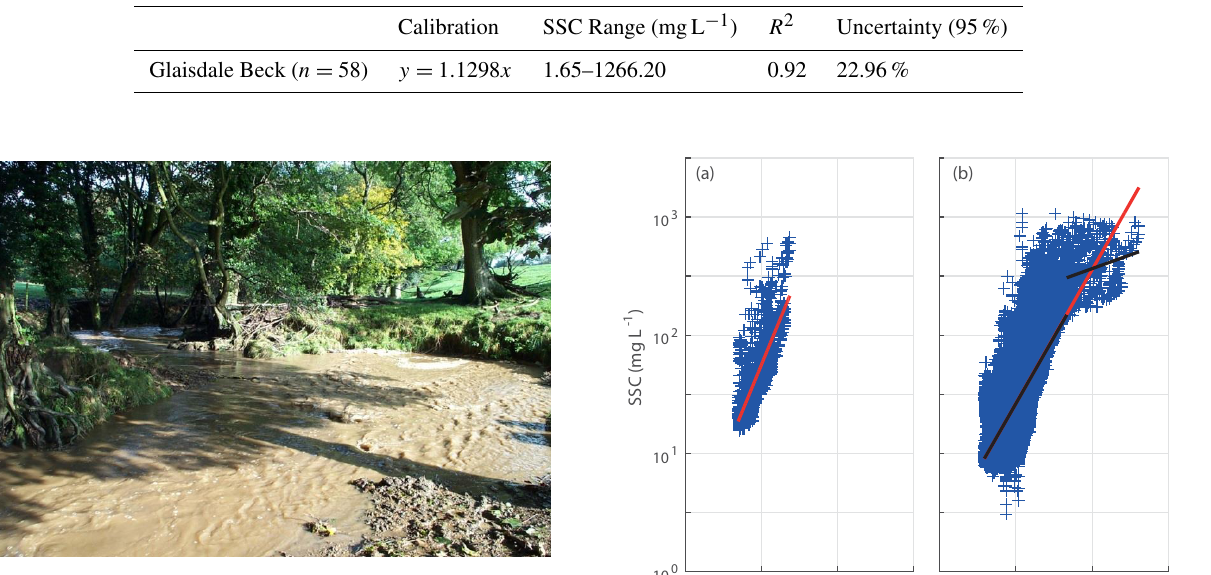
Figure 4. View looking downstream of the channel diversion dur- ing the construction phase. Photograph taken on day of diversion works; 10 October 2007.